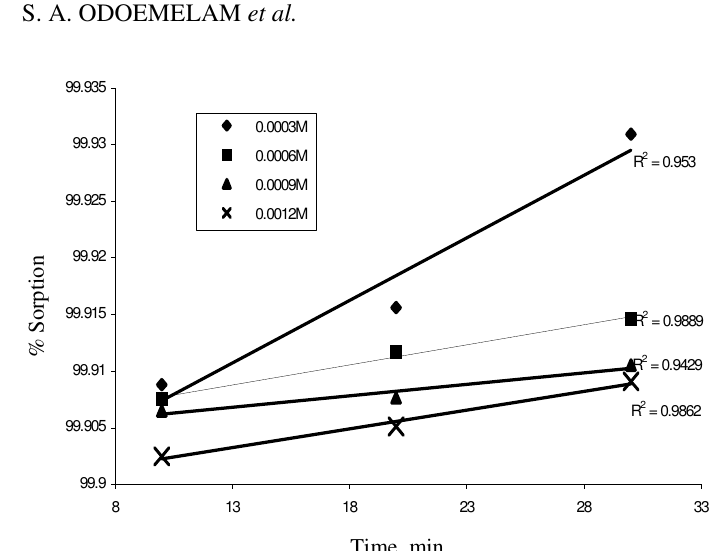
Figure 3. Variation of % Pb ion adsorbed by periwinkle shell with